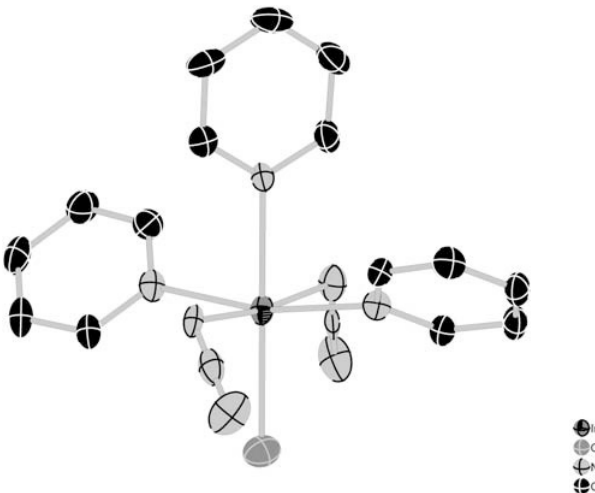
Table 2. Atomic coordinates and displacement parameters (in Å 2 )